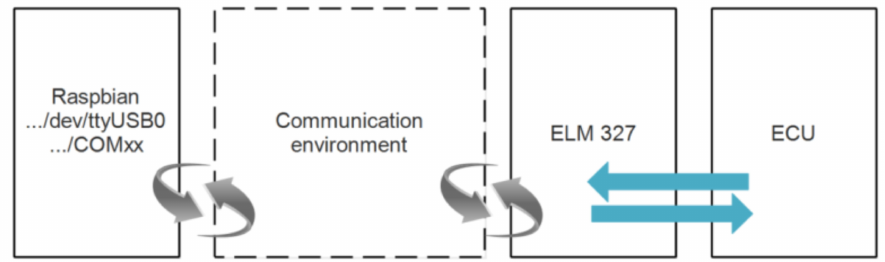
Figure 9. The hardware architecture composed by the OBD adapter (ELM 327) of the electronic control unit (ECU) of the car, connected through a communication environment to the controller ARM Cortex where Raspbian OS runs.